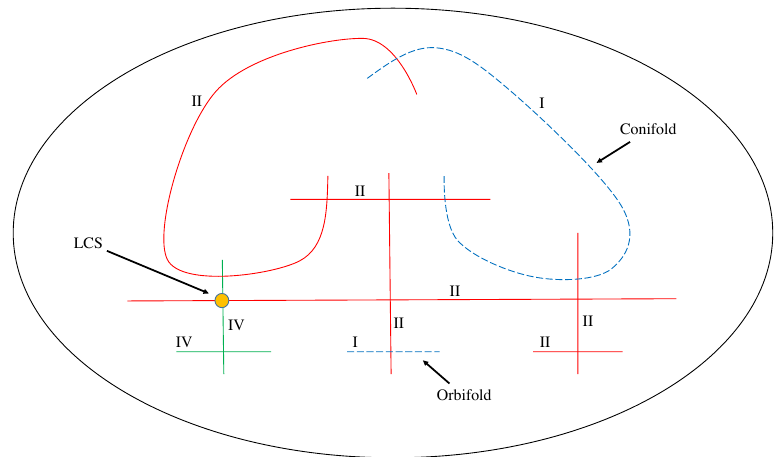
Figure 2 . Figure showing an example (cid:12)eld space with multiple in(cid:12)nite distance loci. The example is the (resolved) complex structure moduli space of the (mirror of the) two parameter Calabi-Yau P 1 ; 1 ; 2 ; 2 ; 2 [8] as studied in [22]. Each in(cid:12)nite distance locus is denoted by a solid line and assigned a type labelled by II, III, or IV. We also show special (cid:12)nite distance loci with dashed lines, and these are associated to type I. Some well-known loci are labelled explicitly, the (cid:12)nite distance conifold and orbifold loci, and the in(cid:12)nite distance large complex-structure point.